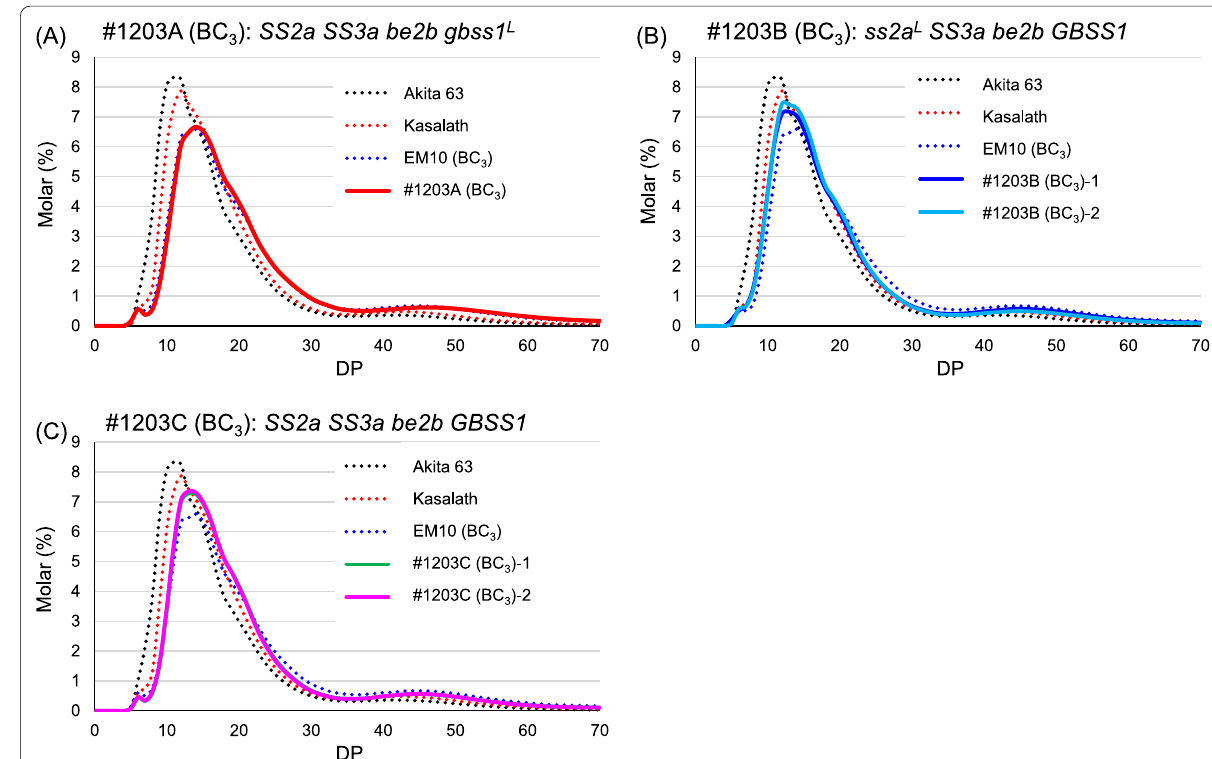
Fig. 4 Comparison of chain length distribution patterns of endosperm amylopectin in #1203 (BC 3 ) lines with those in Akita 63, Kasalath, and EM10 (BC 3 ). a – c Chain length distribution patterns of #1203A (BC 3 ) ( a ), #1203B (BC 3 ) ( b ), and #1203C (BC 3 ) ( c ). Typical patterns obtained in one of at least three replicates are